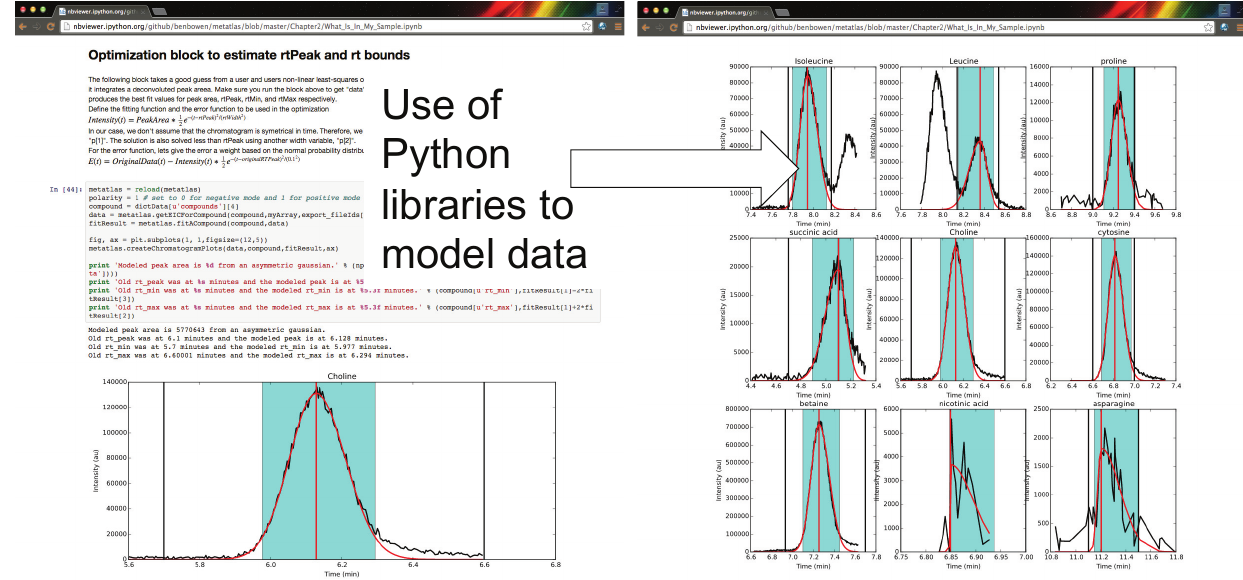
Figure 3. Authenticated users can acquire data from Metabolite Atlas using IPython